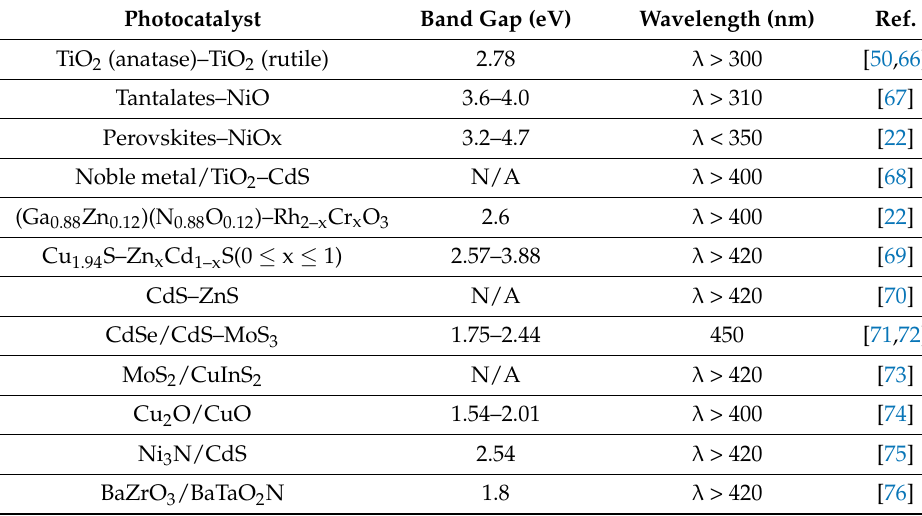
Table 1. Selected photocatalytic systems recently developed for water photosplitting under UV-A ( λ > 300 nm) and visible light ( λ > 400 nm)